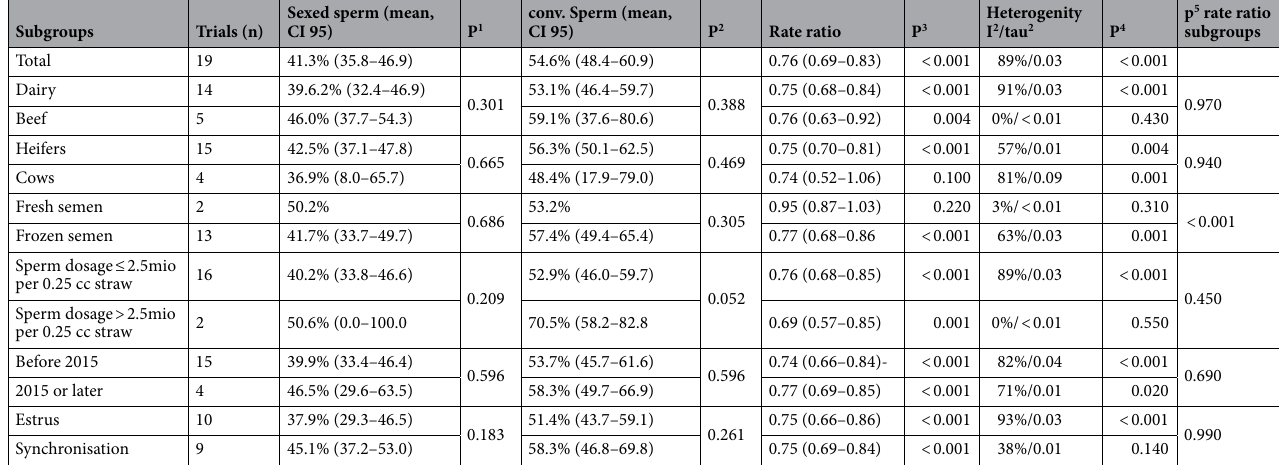
Table 3. Summary of the results of the meta-analysis of calving rates after the use of sex-sorted and conventional sperm with a special focus on the effects of cow type, age, sperm freezing, sperm concentration, timepoint of publication, and cow management. p: determination of statistical significances of: 1: the differences between two subgroups of cows inseminated with sex-sorted sperm using the t-test or Mann– Whitney U Test. 2: the differences between two subgroups with conventional semen using the t-test or Mann– Whitney U Test. 3: the determined rate ratio and odds ratio, respectively, using the Cochran–Mantel–Haenszel test (CMH). 4: the heterogeneity using the chi-square test. 5: the differences between subgroups inseminated with sex-sorted and conventional sperm using the